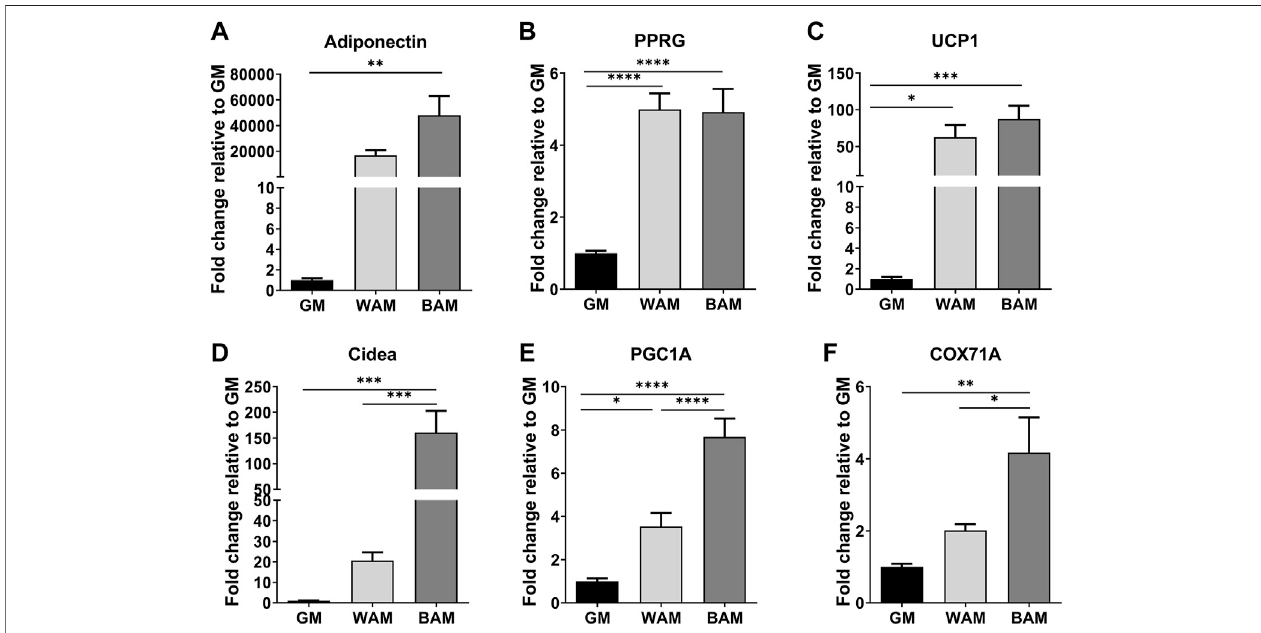
FIGURE 2 | Gene expressions of adipogenic and thermogenic markers. (A,B) Fold expression of the adipogenic genes, adiponectin, and peroxisome proliferator- activated receptor gamma (PPRG). (C – F) Fold expression of several thermogenic genes, uncoupling protein 1 (UCP1), cell death-inducing DNA fragmentation factor alpha-like effector A (Cidea), peroxisome proliferator-activated receptor gamma coactivator 1-alpha (PGC-1 α ), and cytochrome C oxidase subunit VII a polypeptide 1 (COX71A). Results are reported as mean ± standard error ( n = 4). * = p < 0.05, ** = p < 0.01, *** = p < 0.001, and **** = p < 0.0001.